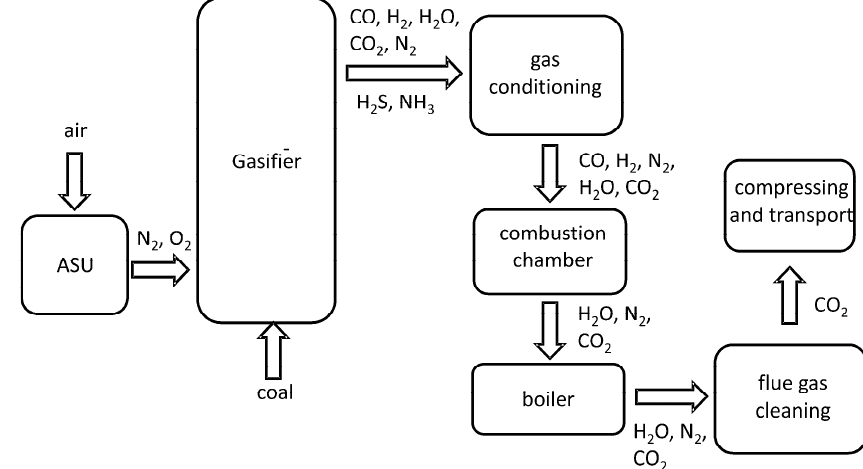
Figure 4. Scheme of a coal-fired IGCC plant with the removal of CO 2 from flue gases.